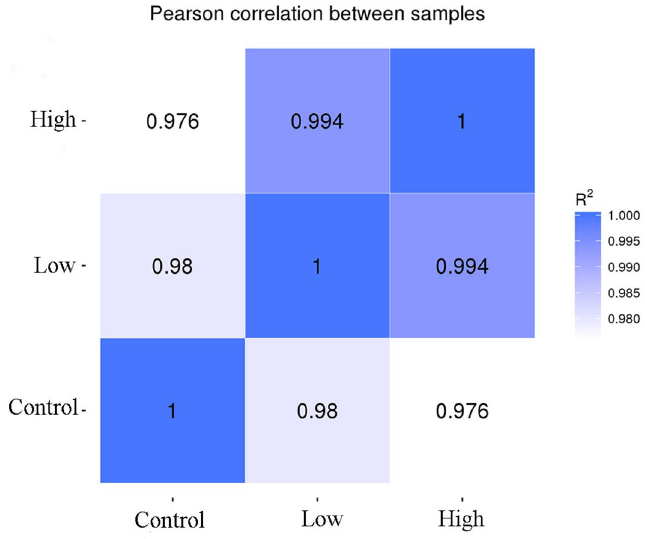
Figure 2. Correlation heatmap between samples (horizontal axis is the square of correlation coefficient of each